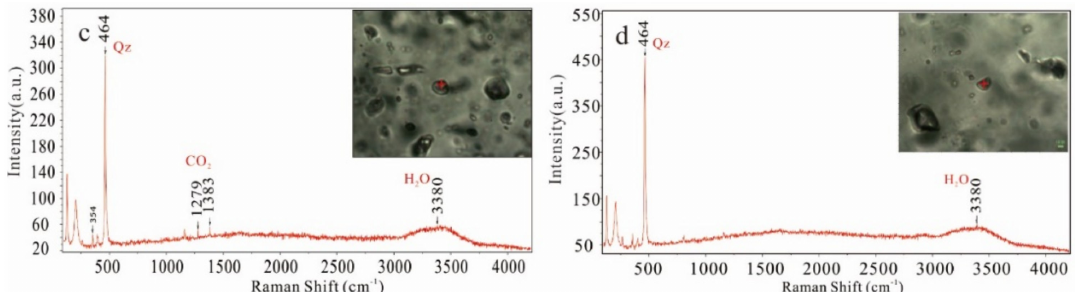
Figure 7. Representative Laser Raman spectra for fluid inclusions from the Juyuan tungsten deposit ( a ) Spectrum for vapor bubbles of CO 2 -H 2 O inclusions in early-stage quartz, containing variable CO 2 and CH 4 ; ( b ) Liquid phase of CO 2 -H 2 O inclusions in early-stage quartz; ( c ) Spectrum for vapor bubbles of CO 2 -H 2 O inclusions in intermediate-stage quartz, containing variable CO 2 and H 2 O; ( d ) Aqueous inclusions in late-stage quartz containing water